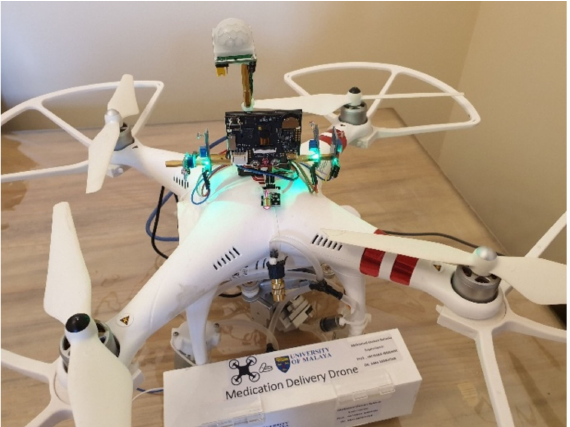
Figure 1. Drone with facial recognition and medical delivery